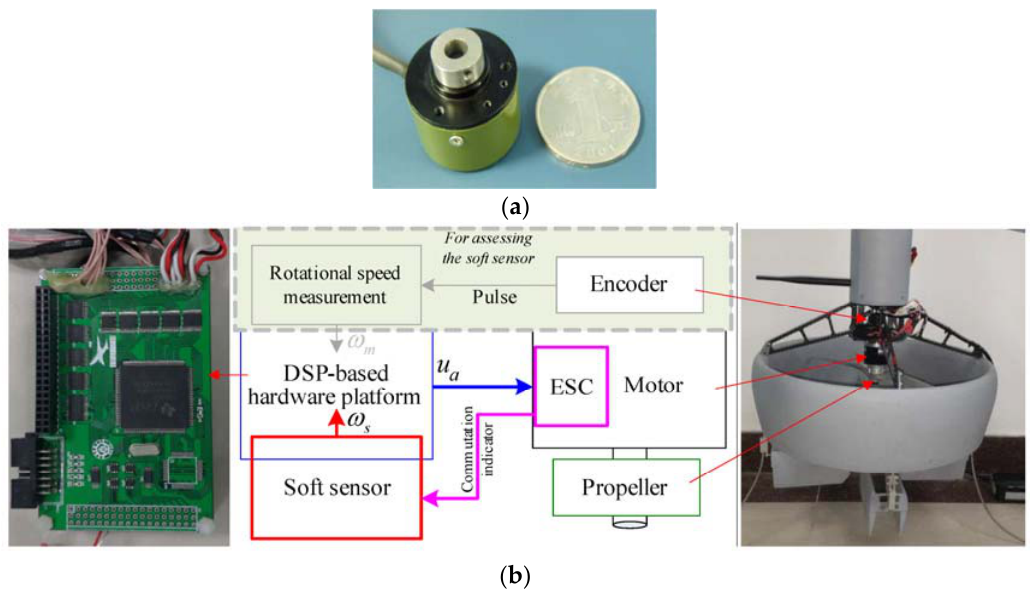
Figure 4. The experimental setup. ( a ) The subminiature encoder; and ( b ) the schematic diagram; DSP: Digital Signal Processor.